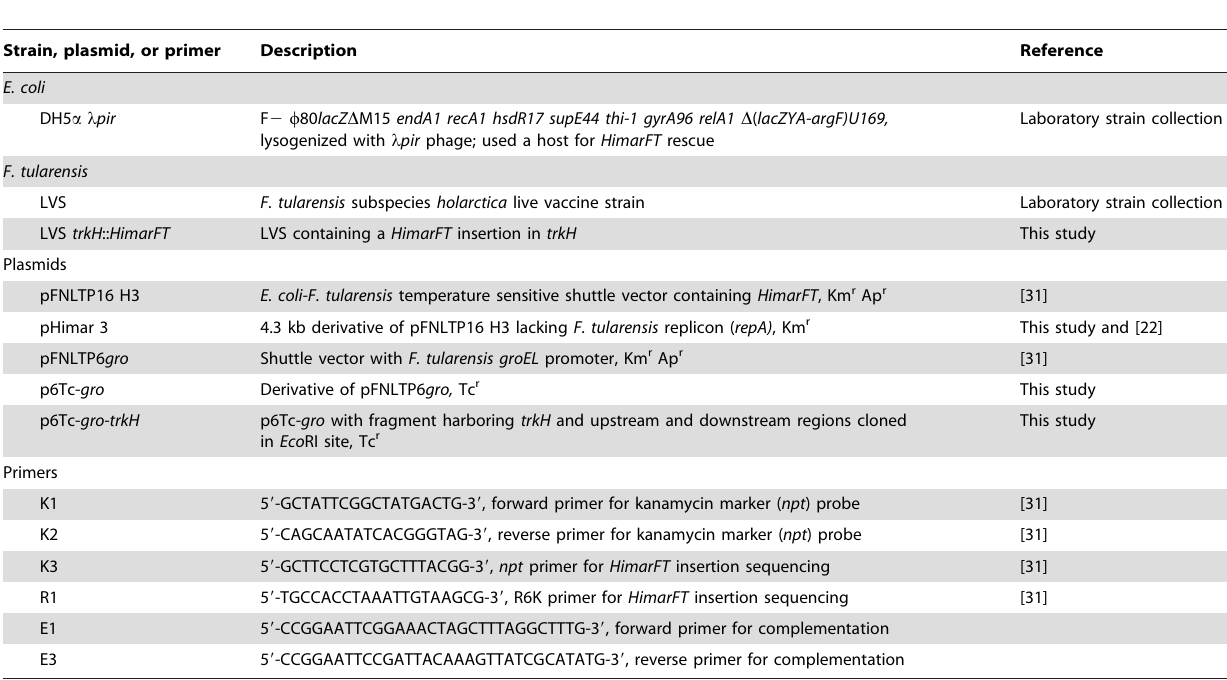
Table 2. Bacterial strains, plasmids, and oligonucleotides used in study.